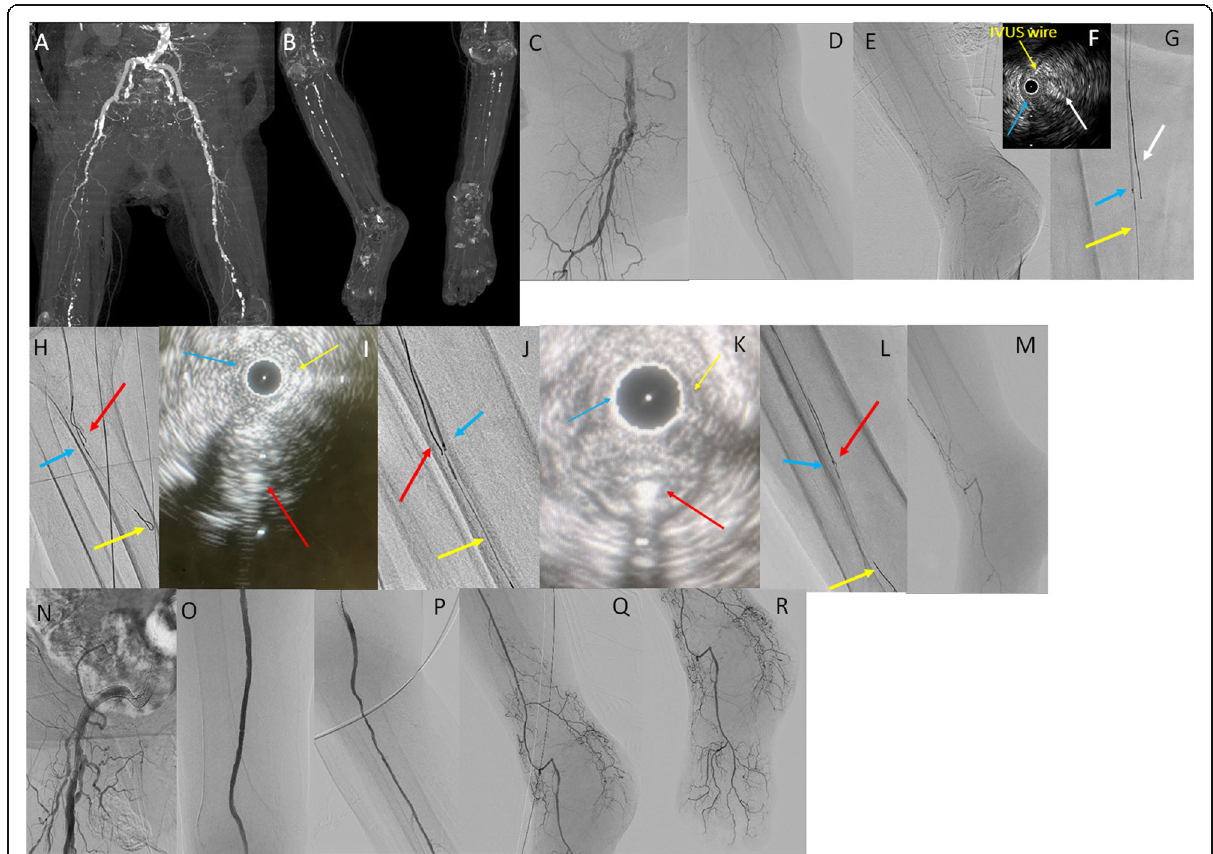
Fig. 3 A, B Preprocedural enhanced computed tomography. C, D, E Control angiography shows total occlusion from the right superficial femoral artery (SFA) to below-the-knee arteries. Distal target vessels are very faint. F IVUS findings of the CTO lesion in the SFA. Yellow arrow: IVUS wire; blue arrow: IVUS transducer; white arrow: 2nd GW in the intraplaque route. G Intravascular ultrasound (IVUS)-guided parallel wiring ( G : SFA). Yellow arrow: 1st guidewire (GW) and IVUS catheter; blue arrow: IVUS transducer; white arrow: 2nd GW advanced into the intraplaque of the chronic total occlusion (CTO) lesion. H, J, L IVUS-guided parallel wiring ( H : distal popliteal artery to peroneal artery; J : peroneal artery; L : distal peroneal artery). Yellow arrow: 1st GW; blue arrow: IVUS transducer; red arrow: 2nd GW advanced into the intraplaque of the CTO lesion. I, K IVUS findings of the CTO lesion in the below-the-knee artery ( I : distal popliteal artery to peroneal artery; K : peroneal artery). Yellow arrow: IVUS wire; blue arrow: IVUS transducer; red arrow: 2nd GW in the intraplaque. M Tip injection from the distal peroneal artery shows the distal true lumen of below-the-ankle arteries. N, O, P, Q, R Final angiography shows sufficient antegrade blood